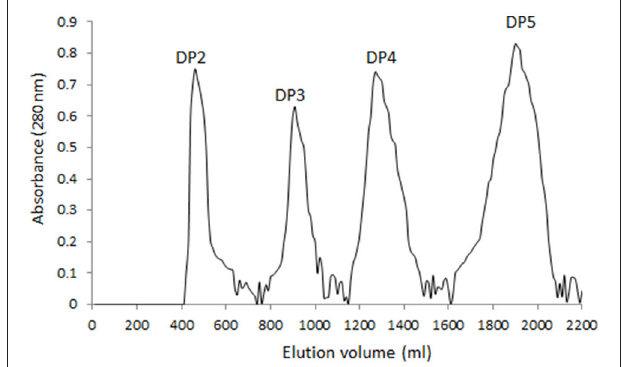
FIGURE 1 | Gel chromatograms of the fractions from digested AOS. A 6 × 60cm Superdex 75 prep grade column was eluted by 50 mm sodium phosphate buffer, pH 7.5 and 300 mM at a linear flow rate of 0.5 cm/min. Each fraction was measured at 280 nm via ultraviolet absorption.